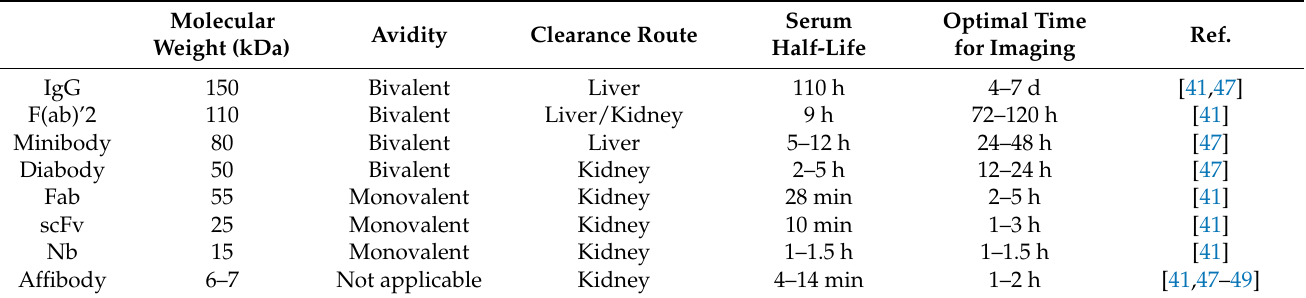
Table 1. Main characteristics of different engineered antibody